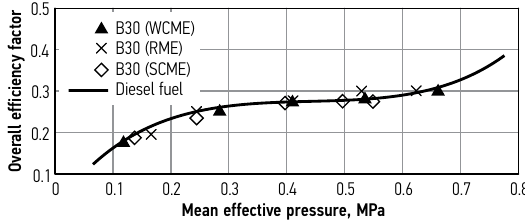
Fig. 8. The dependence of the overall efficiency factor η e of 1Z diesel engine on mean effective pressure P me